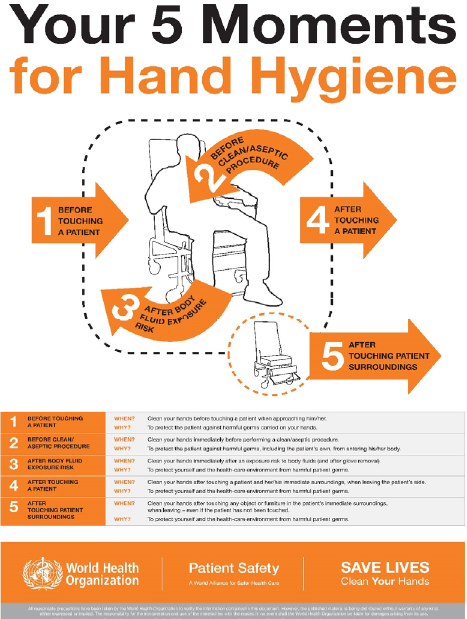
Figure 3. Moments For Hand Hygiene [from WHO Clean care is safer care Your 5 Moments for Hand Hygiene https://www.who.int/gpsc/5may/tools/workplace_reminders/en/ Revised August 2009 (Accessed on March 24, 2020)].